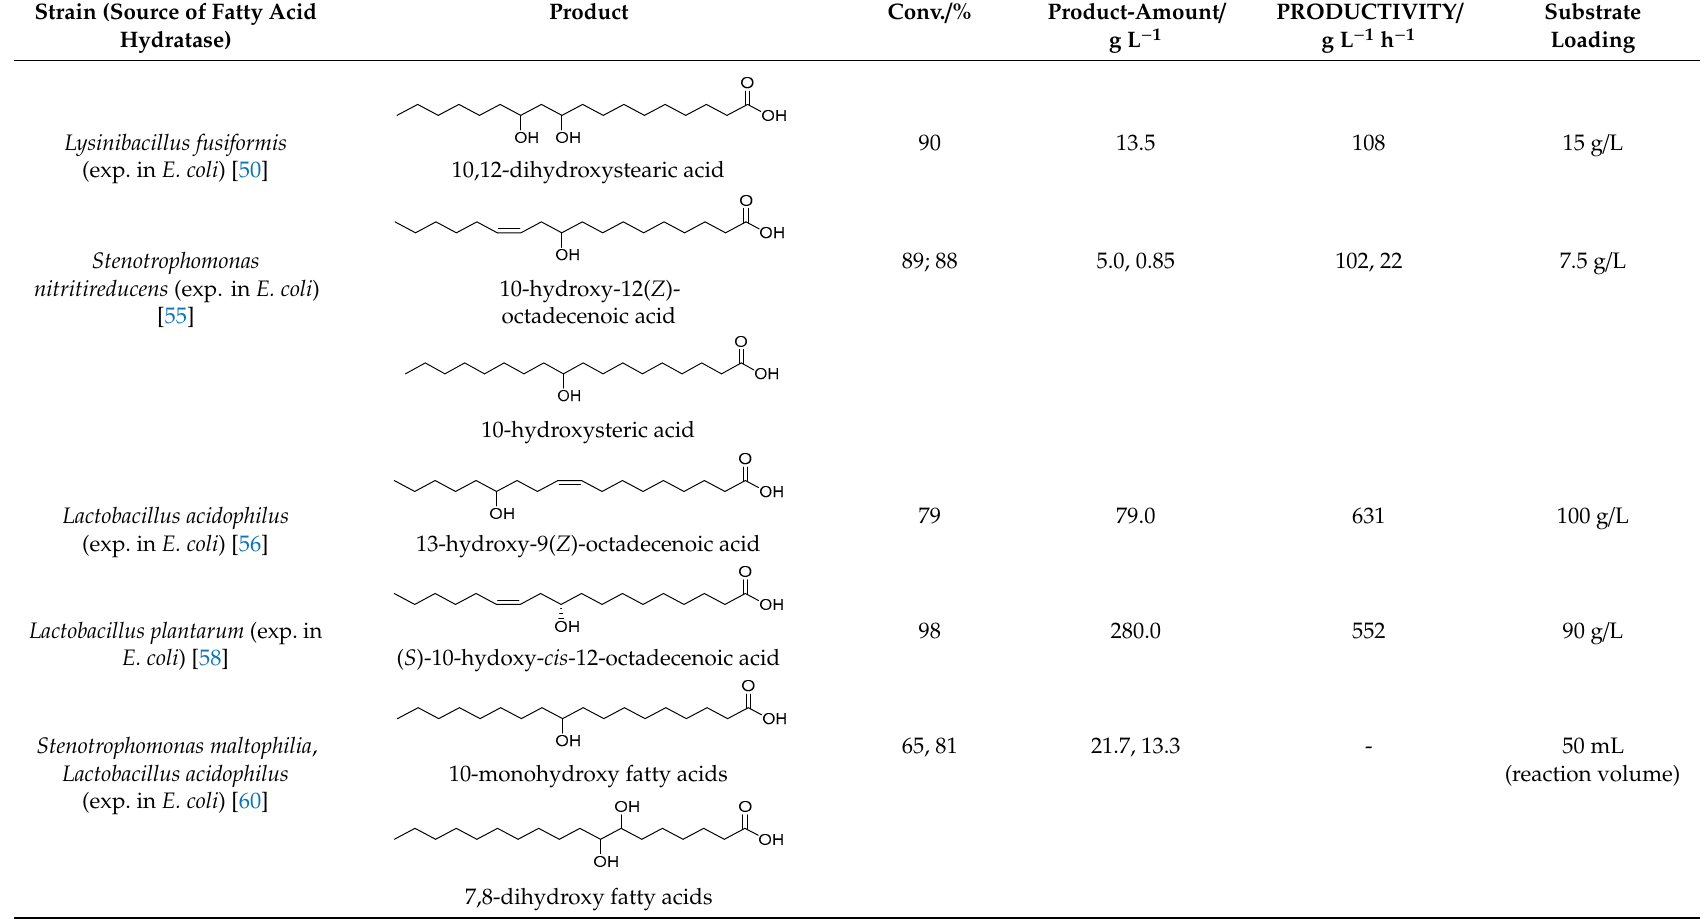
Figure 2. Enzymatic hydrolysis of oils, thus releasing fatty acids and glycerol. 3. Cascade Processes Involving Fatty Acid Hydratase From the year 2013 on, a range of enzymatic cascades combining fatty acid hydratases with other enzymes have been reported in the literature. In such cascades, fatty acid hydratases, in combination with other enzymes, were used to build-up a broad range of industrially relevant products. Such cascades combining various enzymatic steps are of interest also from an industrial perspectives as work-steps of intermediates can be avoided, thus enabling a better process economy with decreased solvent consumption and solvent waste formation. A key prerequisite (and at the same time a challenge) for realizing such cascades is to achieve compatibility between the different enzymatic reaction